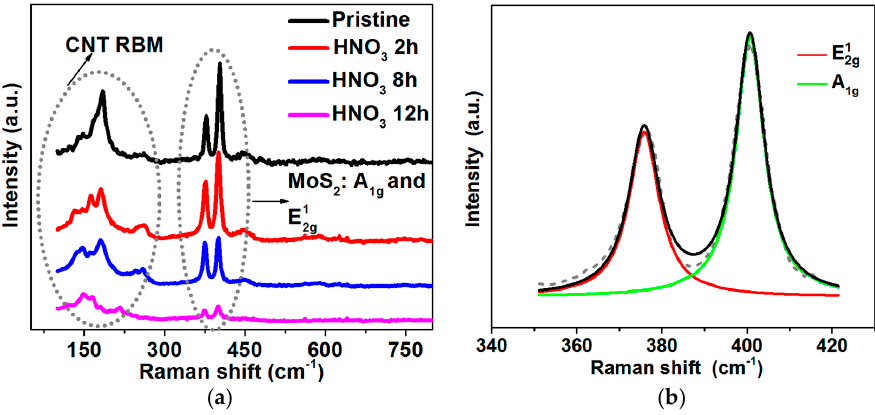
Figure 3. Raman spectrum of MoS 2 @CNT: ( a ) Pristine and treated samples with HNO 3 for 2 h, 8 h and 12 h. ( b ) Deconvolution results of pristine MoS 2 @CNT for E 1 and A 1g modes. 2g